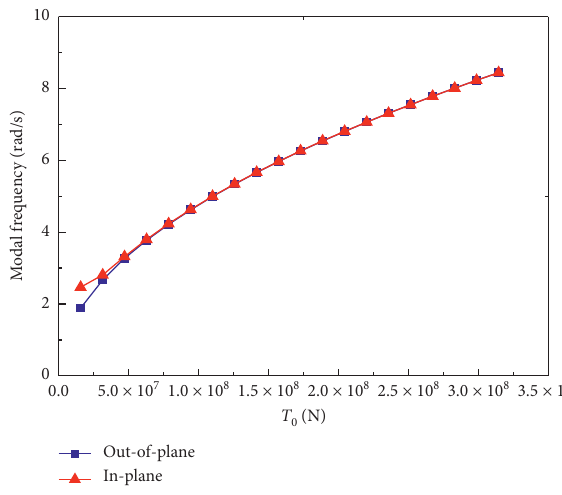
Figure 11: Relationship between modal frequency and initial tension of tether.